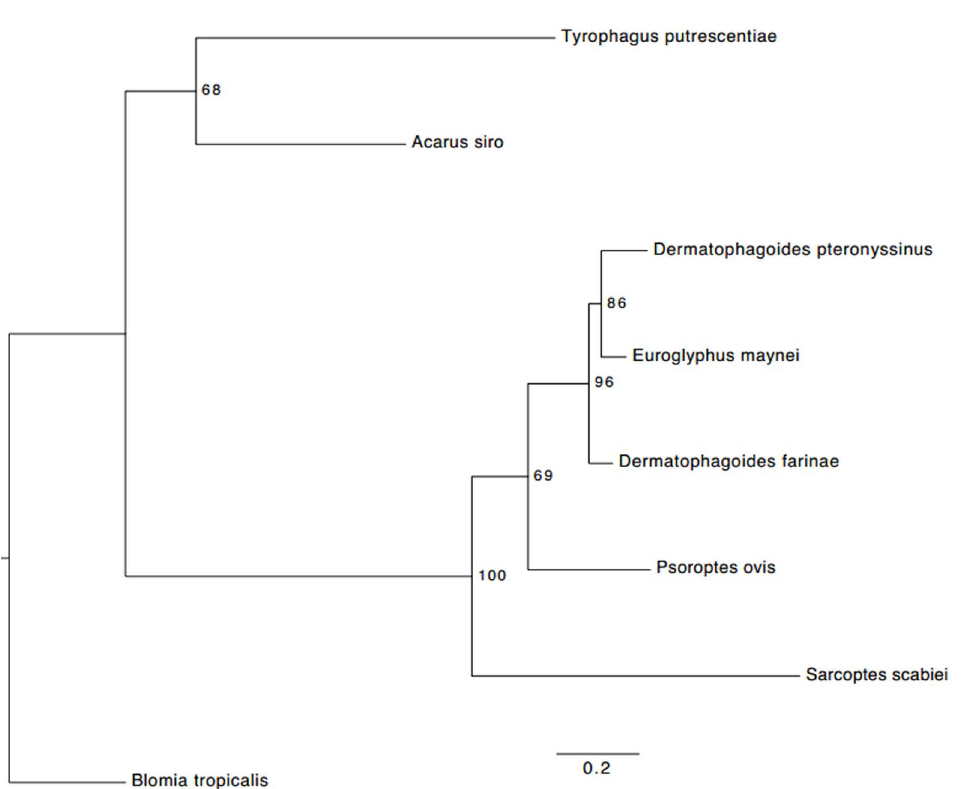
Figure 4. Maximum likelihood tree of the group 1 allergen protein of acariform mites. For each node, nonparametric bootstrap support values (100 replicates) are indicated. The tree was inferred in RAxML ver.7.5.5 [39] using the WAGF model of amino acid evolution as found in PartitionFinder ver. 1.1.1